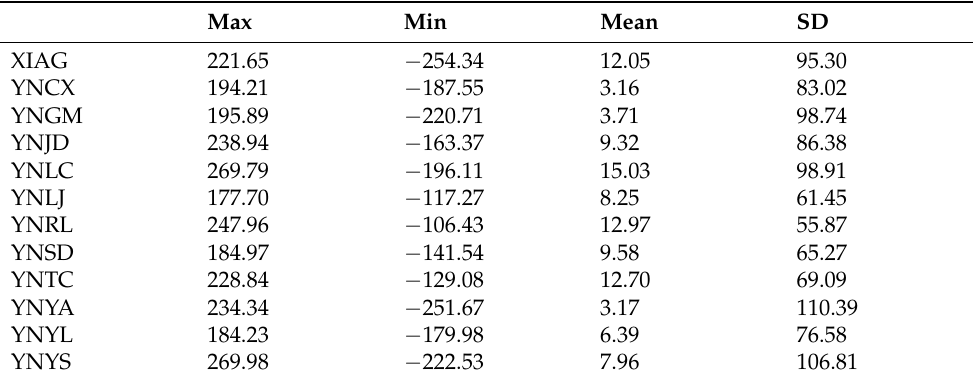
Table 5. Statistics of CORS inverse results for GWSA